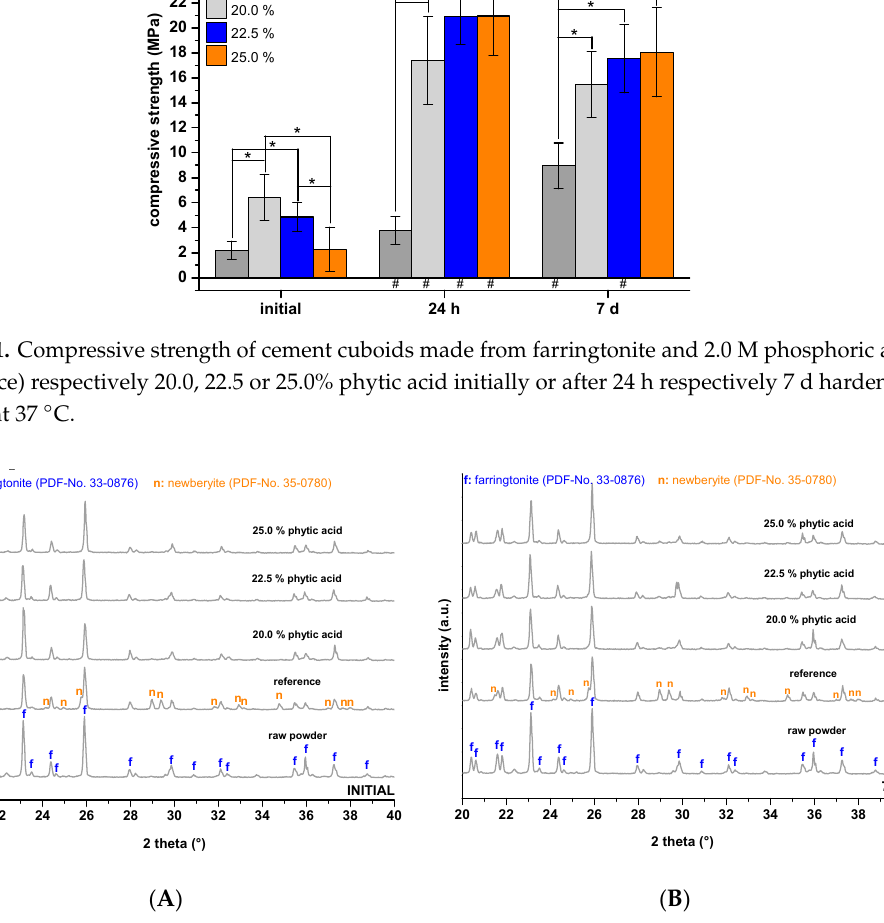
Figure 1. Compressive strength of cement cuboids made from farringtonite and 2.0 M phosphoric acid (reference) respectively 20.0, 22.5 or 25.0% phytic acid initially or after 24 h respectively 7 d hardening in PBS at 37 °C.